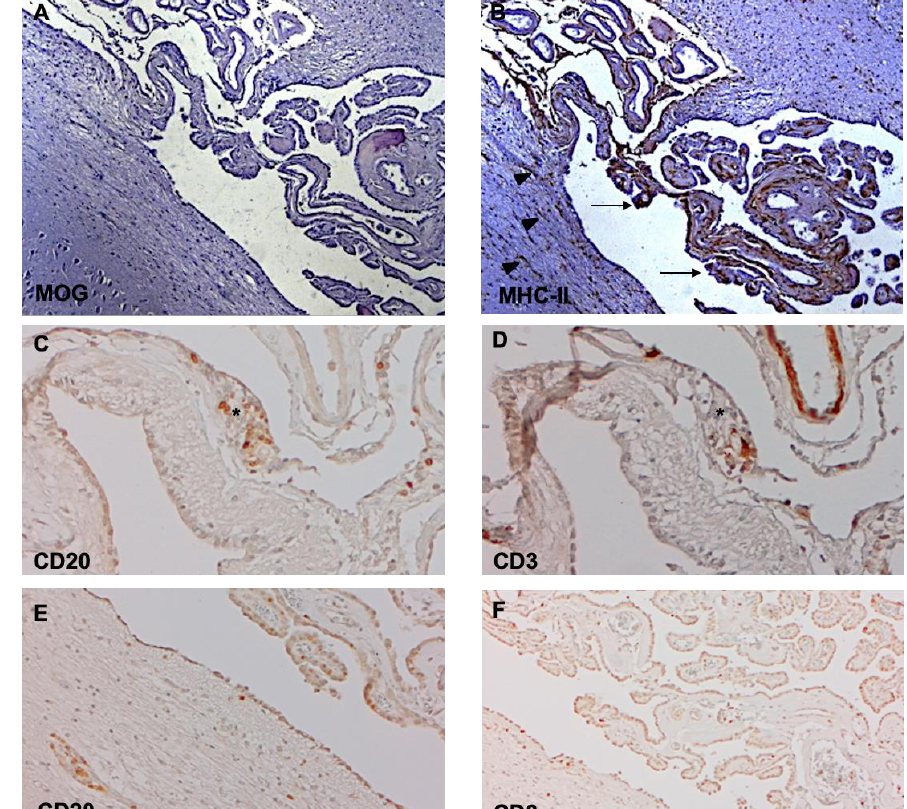
Figure 3. Periventricular demyelination and choroid plexus inflammation in chronic progressive MS. Immunohistochemistry for myelin oligodendrocyte protein (MOG) discloses subependymal demyelination ( A ) and an elevated number of MHC-class II+ activated microglia/macrophages ( B ) in the choroid plexus (arrows) and at the boundary ependyma/CSF (arrowheads). Elevated number of CD20+ B cells ( C , E ) and CD3+ T cells ( D , F ) are detected close to the tela choroidea ( C , D ), which separates the meninges (left) from the choroid plexus (right), and in the choroid plexus ( E , F ). Original magnifications: 100× ( A – F ).